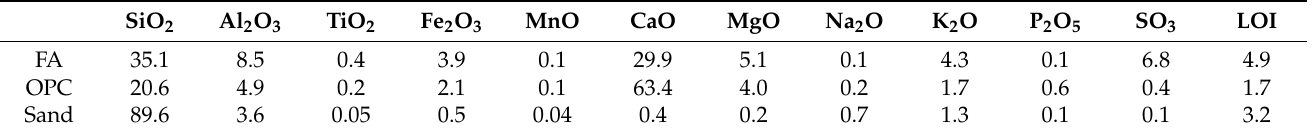
Table 1. The Chemical Composition of Raw Materials Used—Fly Ash (FA), Ordinary Portland Cement (OPC) and Sand, wt.%. LOI—Loss on Ignition at 950 ◦ C. SiO 2